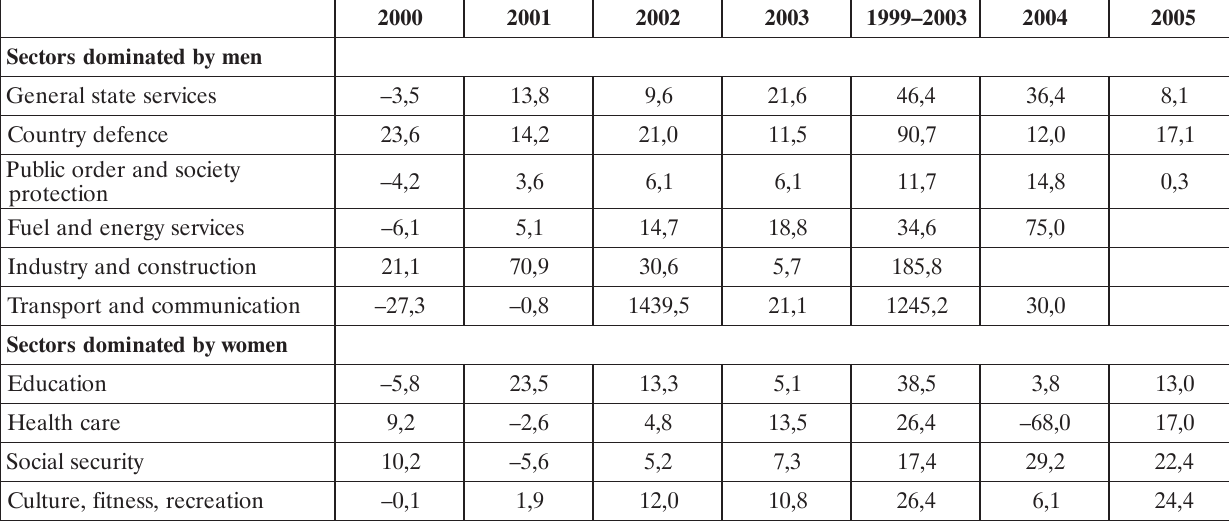
Table 5. State budget expenditure by branches of the economy, annual change,